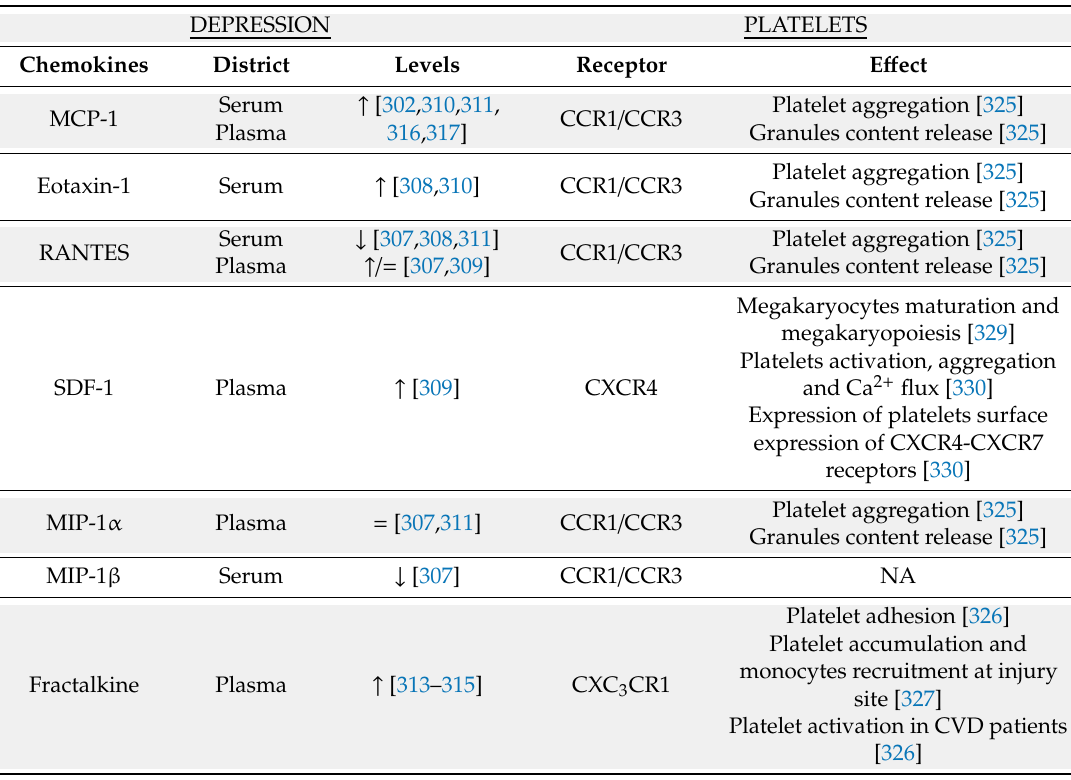
Table 2. Chemokines potentially relevant in the relationship between depression and platelet activation. DEPRESSION PLATELETS Chemokines District Levels Receptor E ff ect Serum Platelet aggregation MCP-1 CCR1 / CCR3 Plasma 316,317]